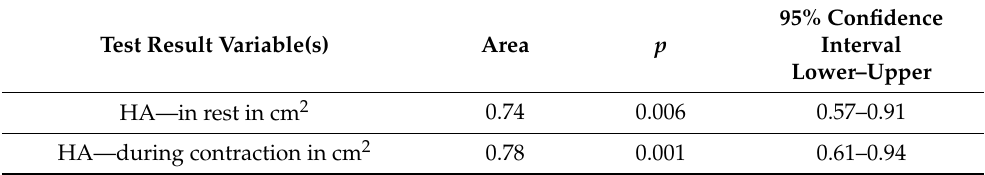
Figure 2. Area under the curve prediction of SUI according to pelvic floor muscle function and morphometry. Legend: HA—urogenital hiatal area in cm 2 according to 3D/4D ultrasound. Maximal voluntary contraction (MvC) and Endurance of MvC in seconds. Blue line: HA during contraction (cm 2 ). Green line: HA at rest (cm 2 ). Pink line: HA during the Valsalva manoeuvre (cm 2 ). Purple line: MvC (cmH 2 O). Brown line: endurance of MvC (seconds). Table 4. Area under the curve prediction of SUI according to pelvic floor muscle function and morphometry.